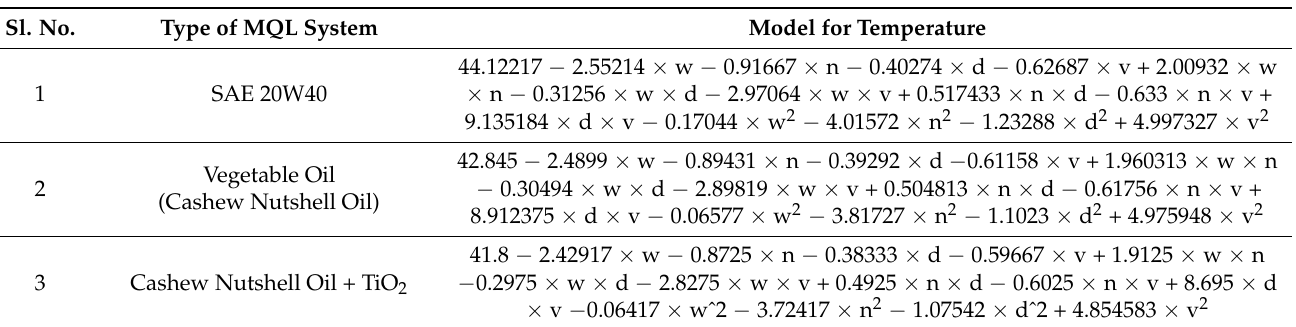
Table 7. Model for